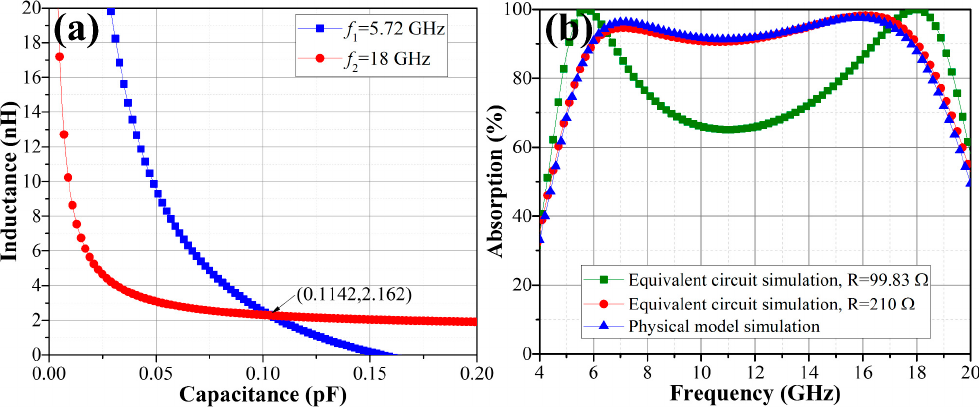
Figure 6. ( a ) The L - C relationship curves at 5.72 GHz and 18 GHz when d = 3.6 mm and ε r = 2.5; ( b ) the simulated absorption performances using ADS and HFSS under normally incident plane waves.